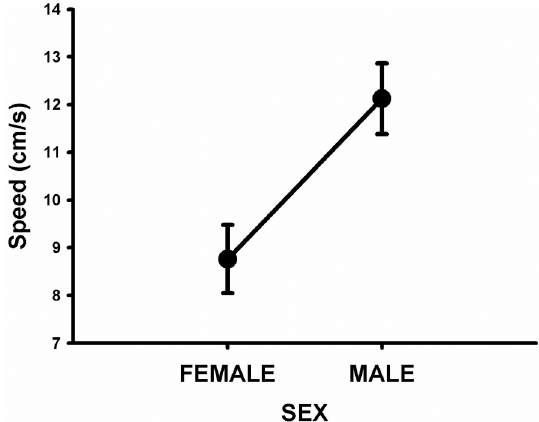
Fig. 2. Differences in climbing speed between males (n = 10) and females (n = 27) of Leucauge venusta .